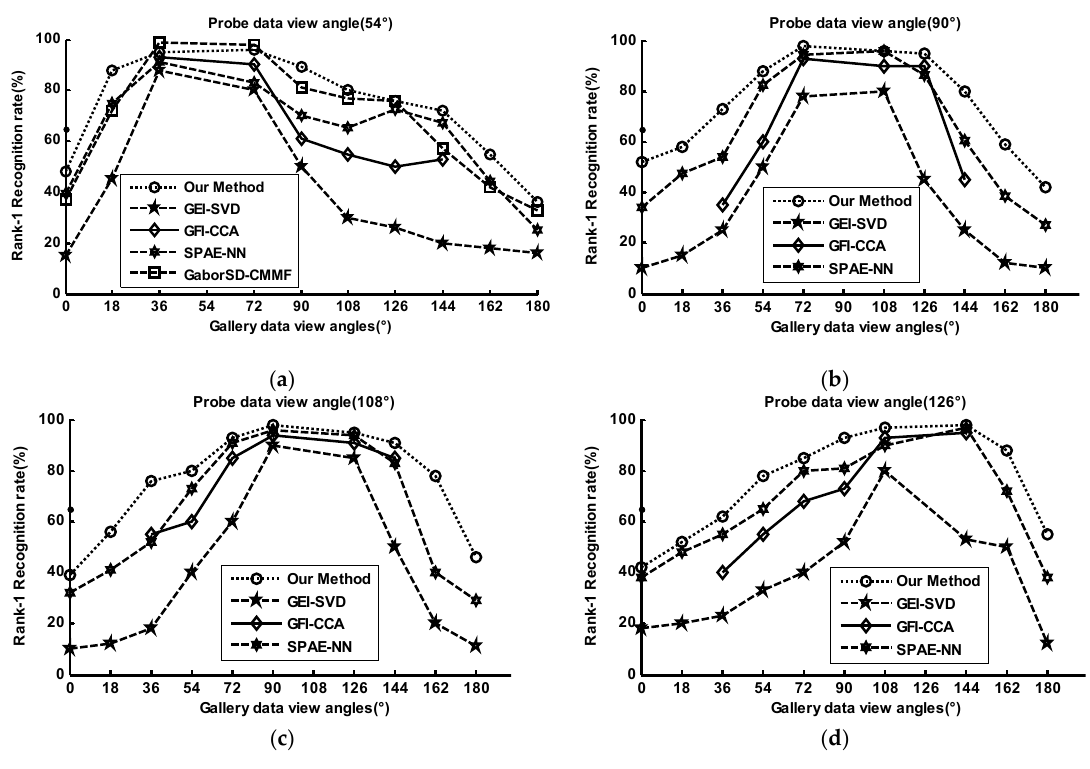
Figure 10. Rank-1 recognition rates of different methods.